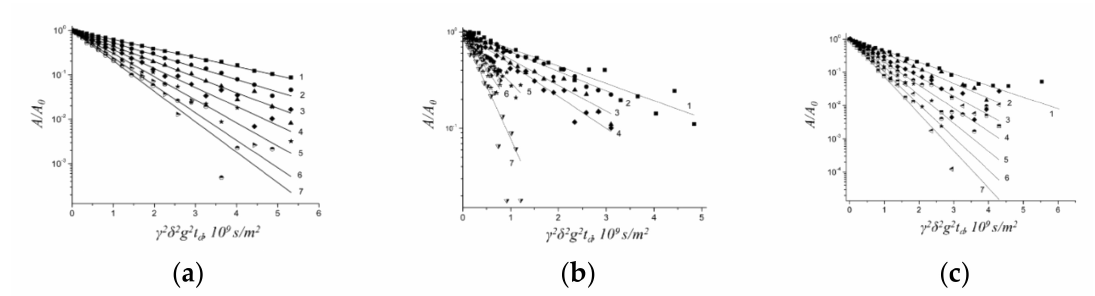
Figure 5. Di ff usion decays of 7 Li ( a ), 23 Na ( b ), 133 Cs ( c ) nuclei NMR signals in appropriate ionic form of MSC membrane at RH = 95% and di ff erent temperatures 1–20 ◦ C, 2–30 ◦ C, 3–40 ◦ C, 4–50 ◦ C, 5–60 ◦ C, 6–70 ◦ C, 7–80 ◦ C.